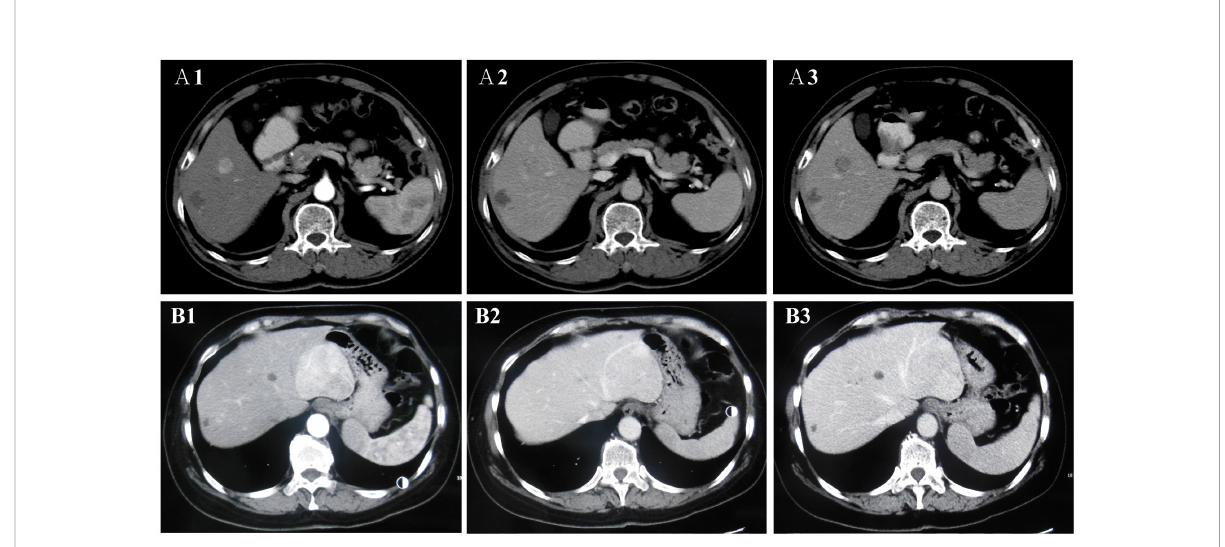
FIGURE 2 The two enhancement patterns of CECT. The enhancement patterns of CECT included two types: “ fast in and fast out ” (FIFO) and “ fast in and slow out ” (FISO). A1, A2, and A3 are CECT images of lesions in the patient 10. (A1) In arterial phase, the lesions were obviously enhanced with high-density; (A2, A3) In portal vein phase and delayed phase, the lesion was observed low-density. CECT showed “ FIFO ” enhancement pattern. B1, B2, and B3 are CECT images of lesions in the patient 4. (B1) In arterial phase, the lesions were obviously enhanced with high-density and large blood vessels were observed at the edge of the lesion; (B2) In portal vein phase and delayed phase, the lesion was observed iso-density and low-density. (B3) In delayed phase, the lesion was observed low-density. CECT showed “ FISO ” enhancement